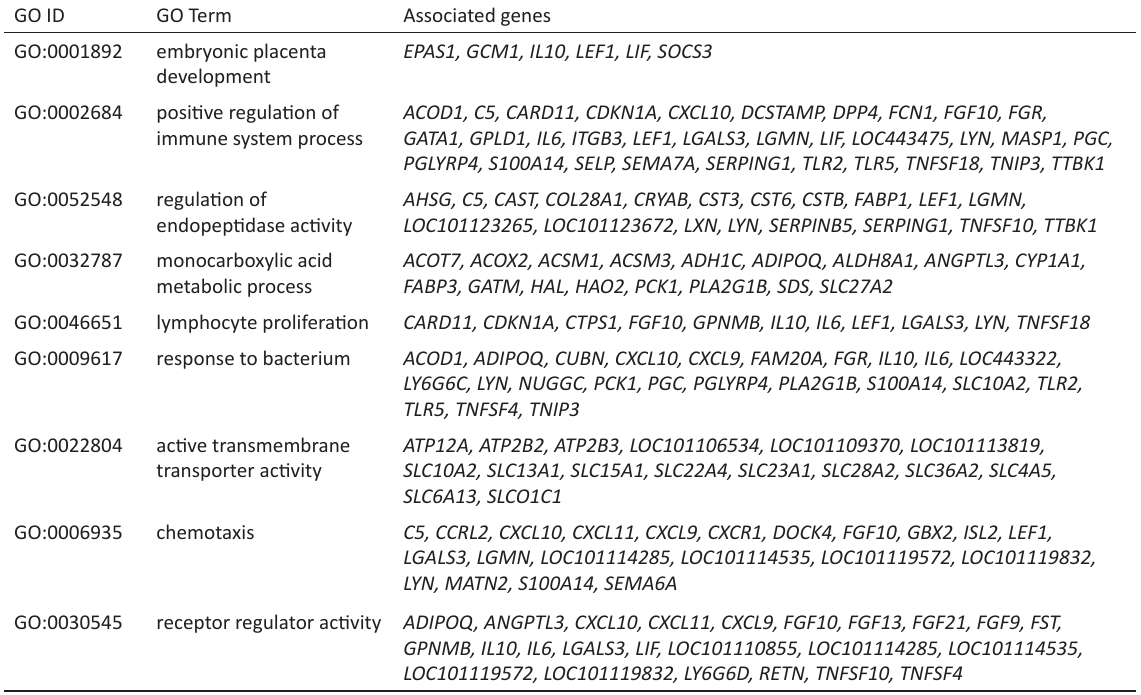
Table 4. Selected GO terms associated with genes that were upregulated in endometrium having elongated (E) embryos (for more details and complete list, see Table